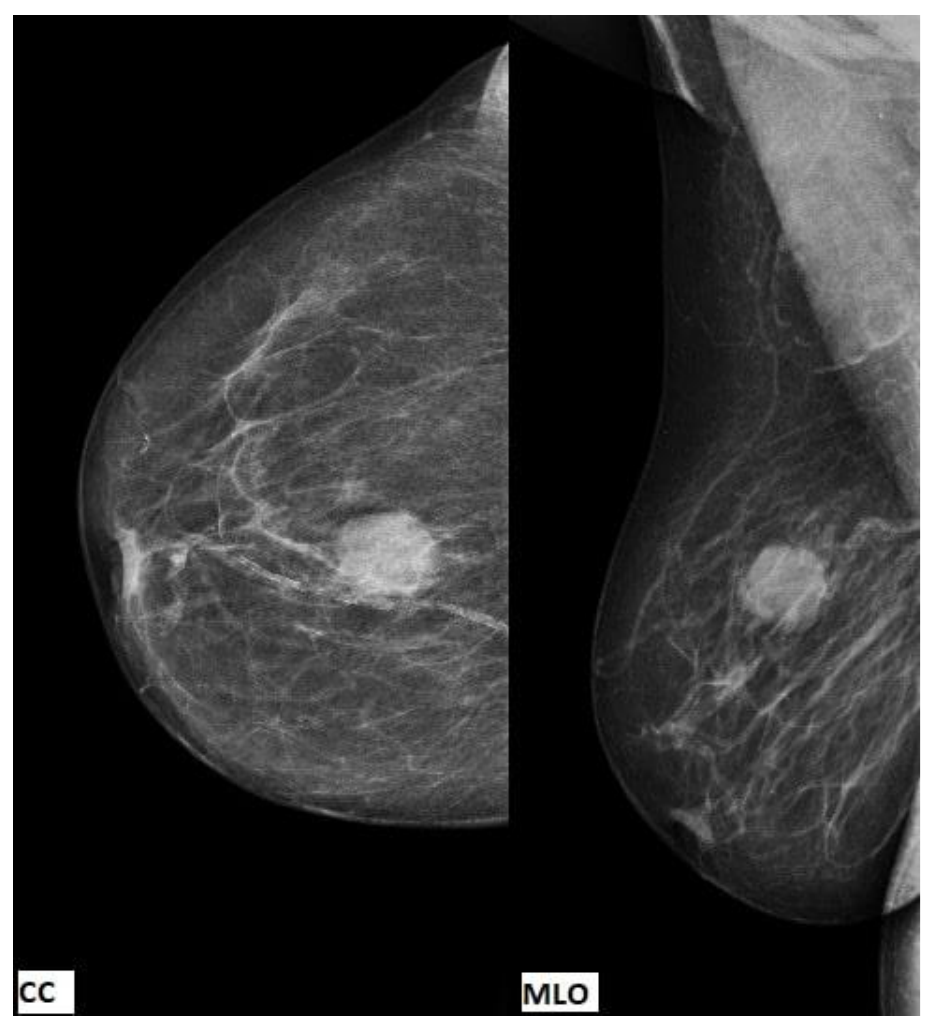
Figure 1. The cranial caudal (CC) view and the mediolateral oblique (MLO) view showing a mass with well-defined borders in the right breast, without suspicious breast calcifications or axillar lymph nodes.